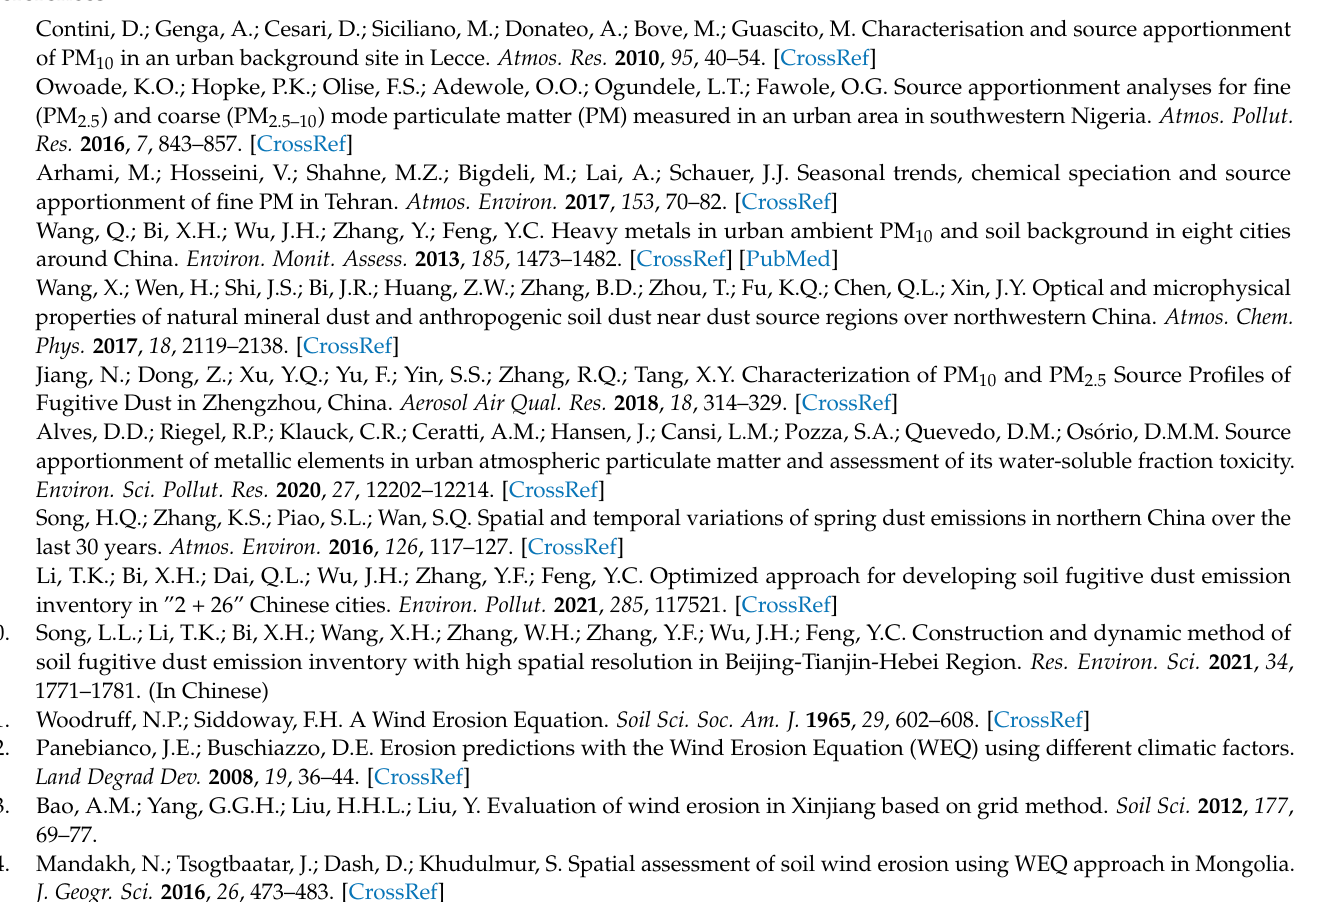
Figure S2: Spatial distribution of soil texture types; Figure S3: Daily temperature, wind speed, and rainfall data in 2018; Table S1: Soil erodibility index; Table S2: Expose parameters of potentially toxic elements; Table S3: Reference doses and slope factors of potentially toxic elements; Table S4: Proportion of soil texture in six cities; Table S5: Annual mean values of various meteorological parameters; Table S6: VCF for each month in 2018; Table S7: Atmospheric PM 2.5 concentration